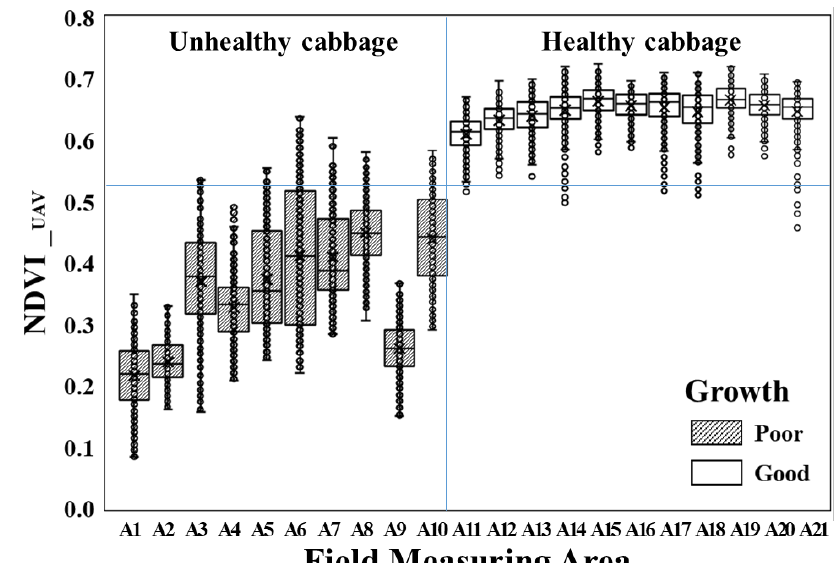
Figure 13. Comparison of NDVI according to growth conditions using UAV imagery.